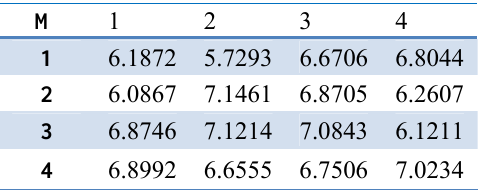
Table 1 Image entropy matrix (N=4)